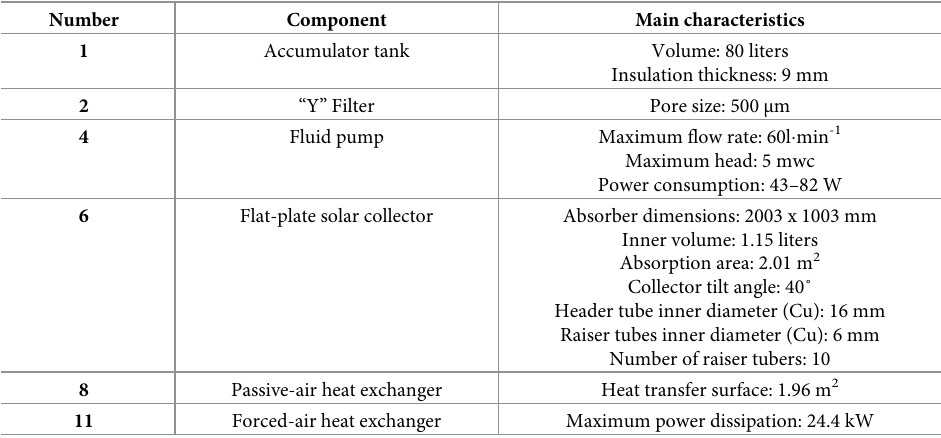
Table 1. Characteristics of the main elements.